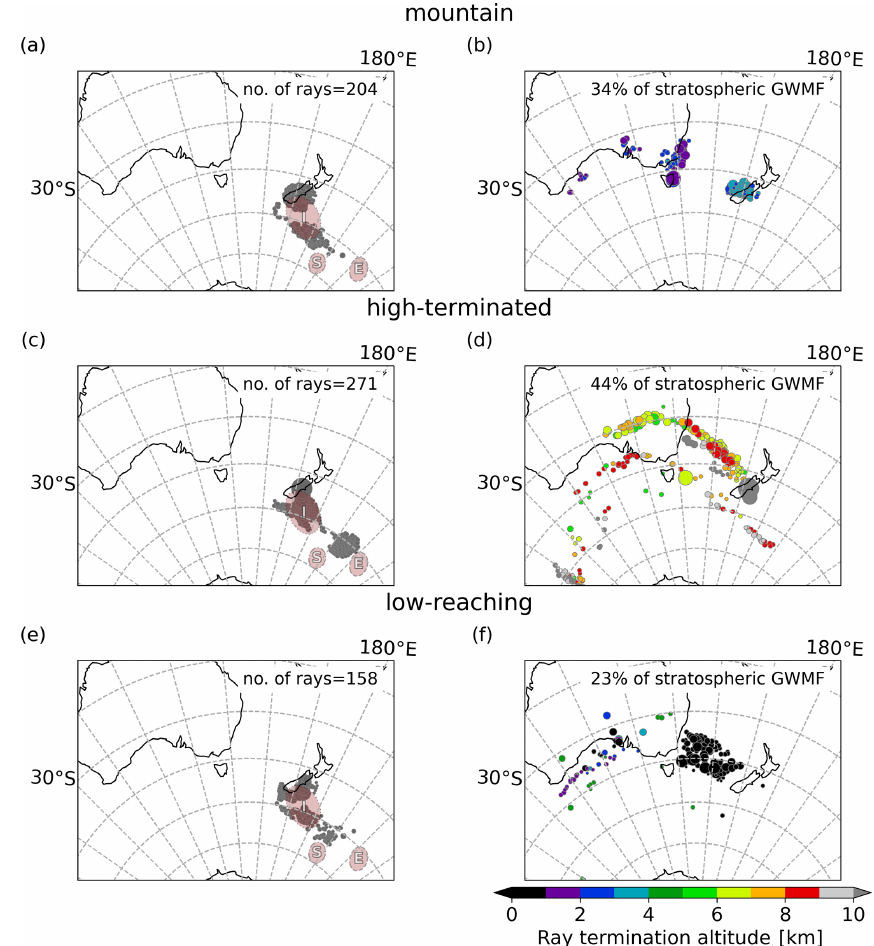
Figure 13. Same as Fig. 4 but for an S3D analysis altitude of